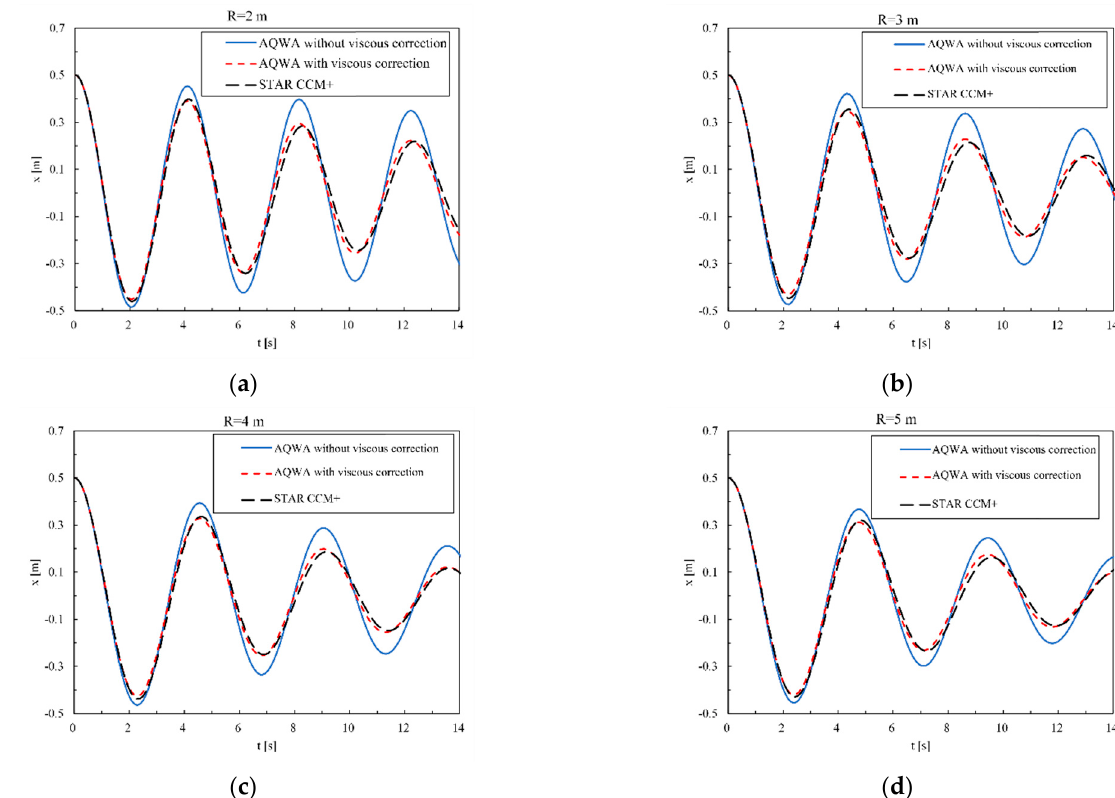
Figure 3. Attenuation motion of floaters with different radii before and after viscosity correction compared with STAR CCM+: ( a ) R = 2 m; ( b ) R = 3 m; ( c ) R = 4 m; ( d ) R = 5 m.